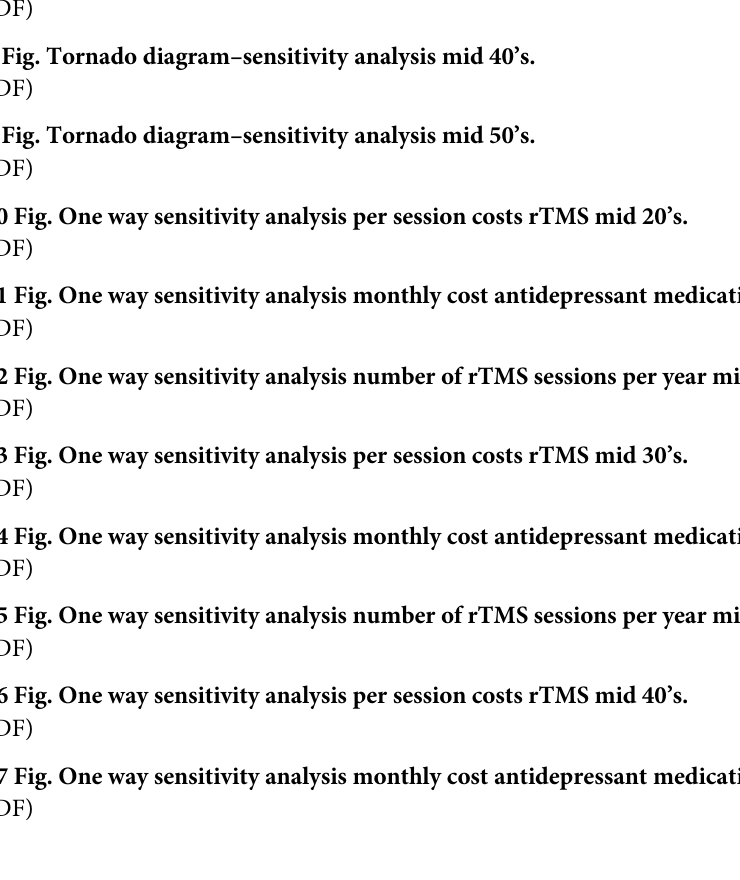
S1 Fig. Cost-effectiveness analysis graph mid 20’s. (PDF) S2 Fig. Incremental cost scatterplot mid 20’s. (PDF) S3 Fig. Incremental cost scatterplot mid 30’s. (PDF) S4 Fig. Incremental cost scatterplot mid 40’s. (PDF) S5 Fig. Incremental cost scatterplot mid 50’s. (PDF) S6 Fig. Tornado diagram–sensitivity analysis mid 20’s. (PDF) S7 Fig. Tornado diagram–sensitivity analysis mid 30’s. (PDF) S8 Fig. Tornado diagram–sensitivity analysis mid 40’s. (PDF) S9 Fig. Tornado diagram–sensitivity analysis mid 50’s. (PDF) S10 Fig. One way sensitivity analysis per session costs rTMS mid 20’s. (PDF) S11 Fig. One way sensitivity analysis monthly cost antidepressant medications mid 20’s. (PDF) S12 Fig. One way sensitivity analysis number of rTMS sessions per year mid 20’s. (PDF) S13 Fig. One way sensitivity analysis per session costs rTMS mid 30’s. (PDF) S14 Fig. One way sensitivity analysis monthly cost antidepressant medications mid 30’s. (PDF) S15 Fig. One way sensitivity analysis number of rTMS sessions per year mid 30’s. (PDF) S16 Fig. One way sensitivity analysis per session costs rTMS mid 40’s. (PDF) S17 Fig. One way sensitivity analysis monthly cost antidepressant medications mid 40’s.